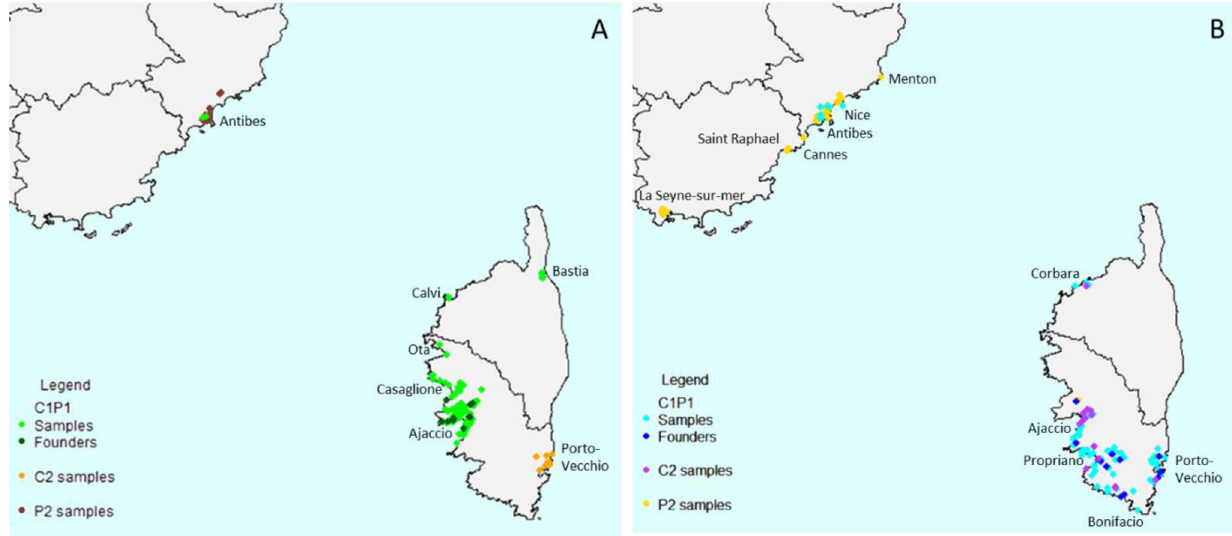
Fig. 4 Distribution of the French X. fastidiosa infected samples used in this study. A ST6 plant samples and strains, B ST7 plant samples and